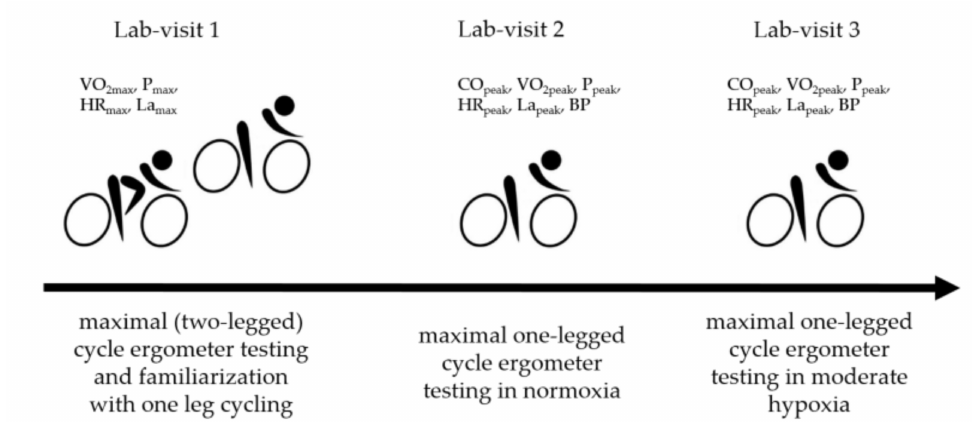
Figure 1. Experimental design. Blood pressure, BP; cardiac output, CO; heart rate, HR; lactate concentration, La; oxygen uptake, VO 2 ; power output,